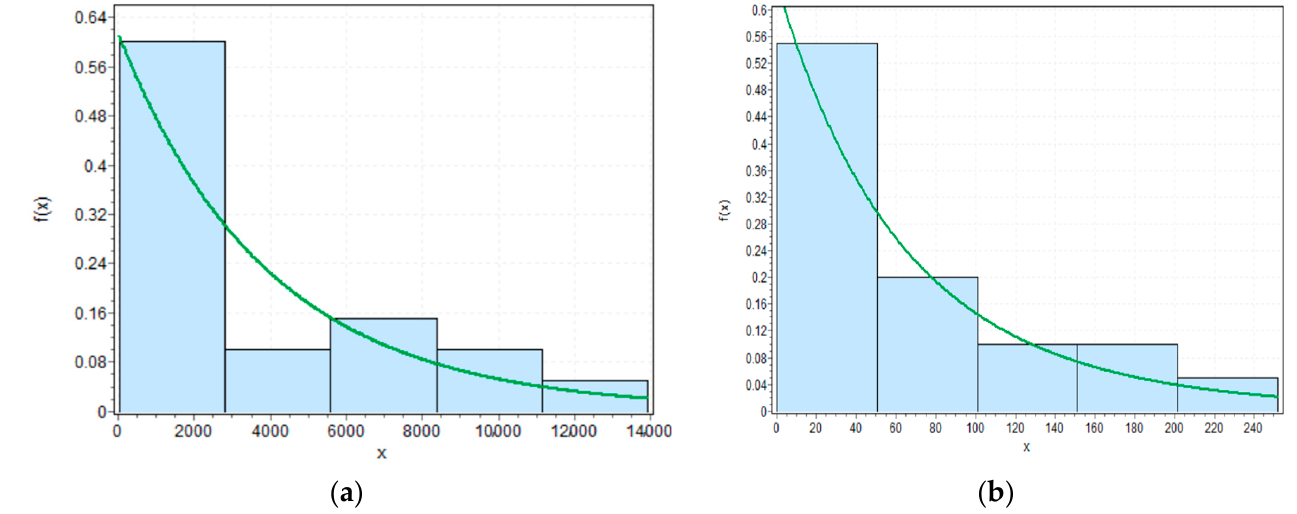
Figure 4. histogram of excess loss on ( a ) the houses damaged and ( b ) deaths. Figure 4. Histogram of excess loss on ( a ) the houses damaged and ( b ) deaths.